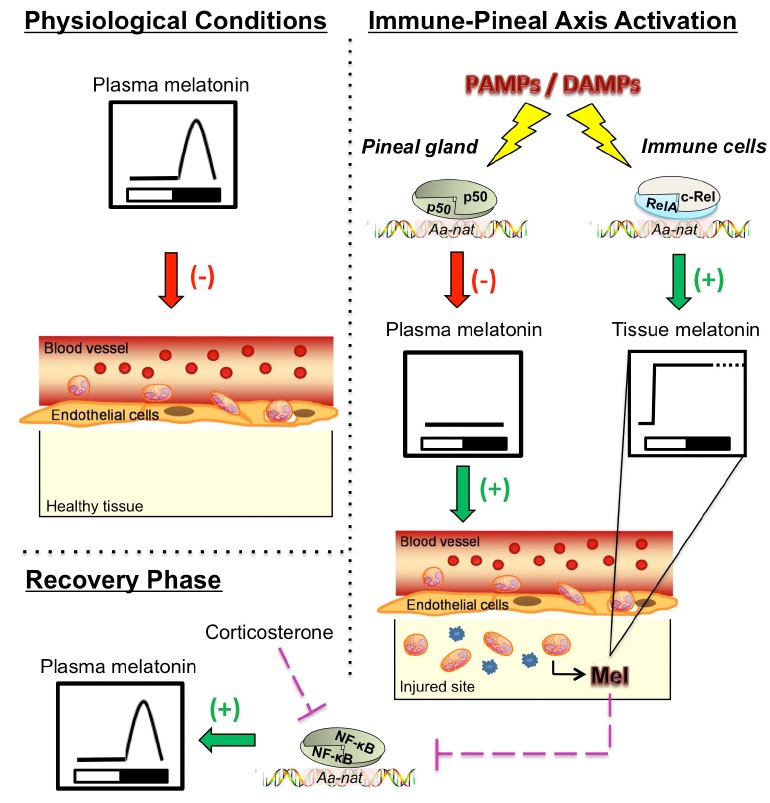
Figure 1. Schematic representation of NF- κ B-mediated shift in melatonin sources upon activation of the immune-pineal axis. Left side —Physiological conditions: Melatonin synthesized at nighttime by the pineal gland impairs leukocyte